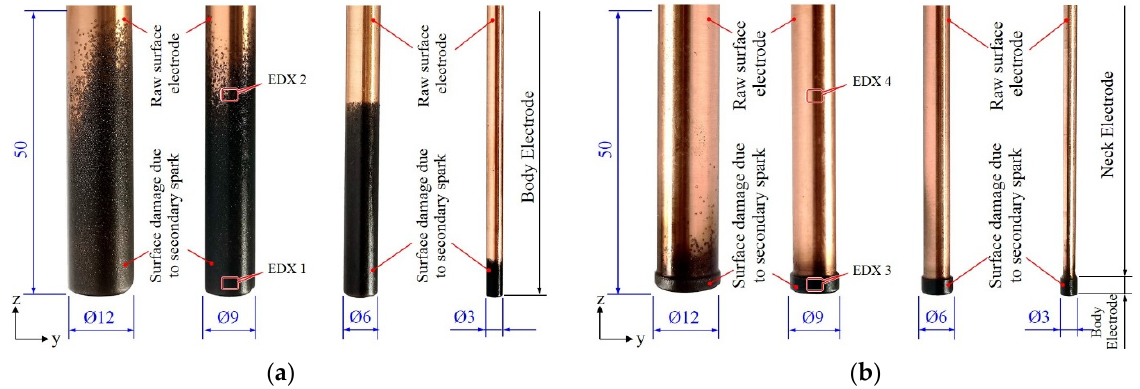
Figure 5. Photography of secondary spark on the electrode. ( a ) Conventional electrode (CE); ( b ) step cylindrical electrode (SCE).